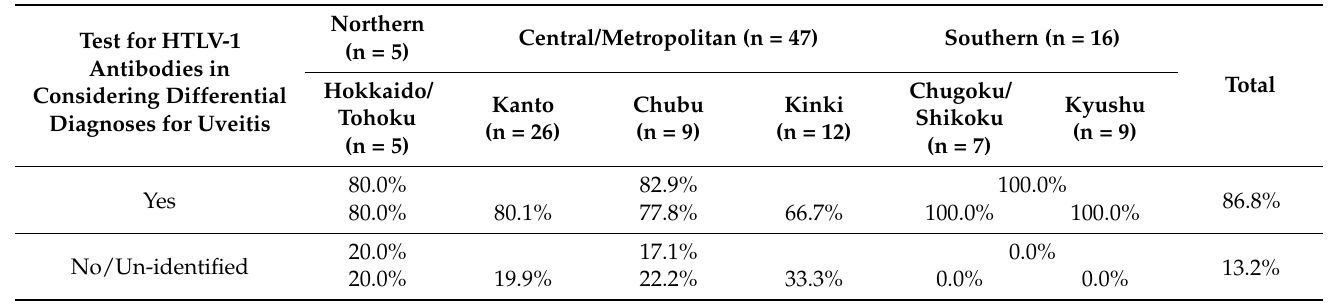
Table 2. Testing for HTLV-1 antibodies when an HTLV-1-related ocular manifestation is